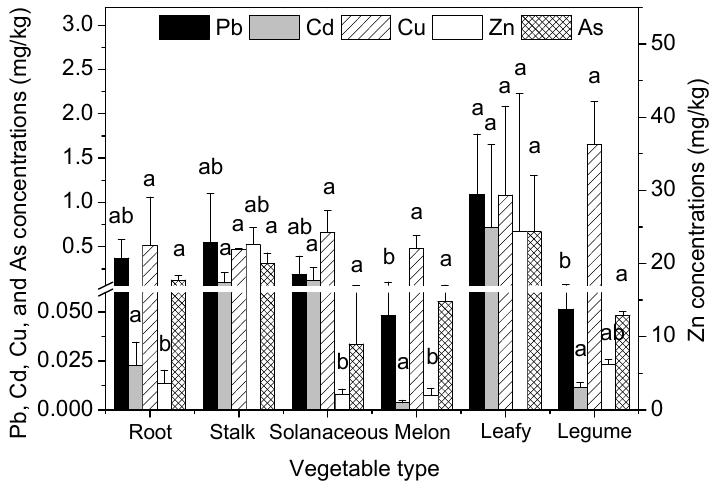
Figure 1. Heavy metal concentrations in the edible parts of six vegetable types (mg/kg, f.w.). Error bars indicate standard error of three replicates. The different letters indicate significant difference at p < 0.05 (Duncan’s test).